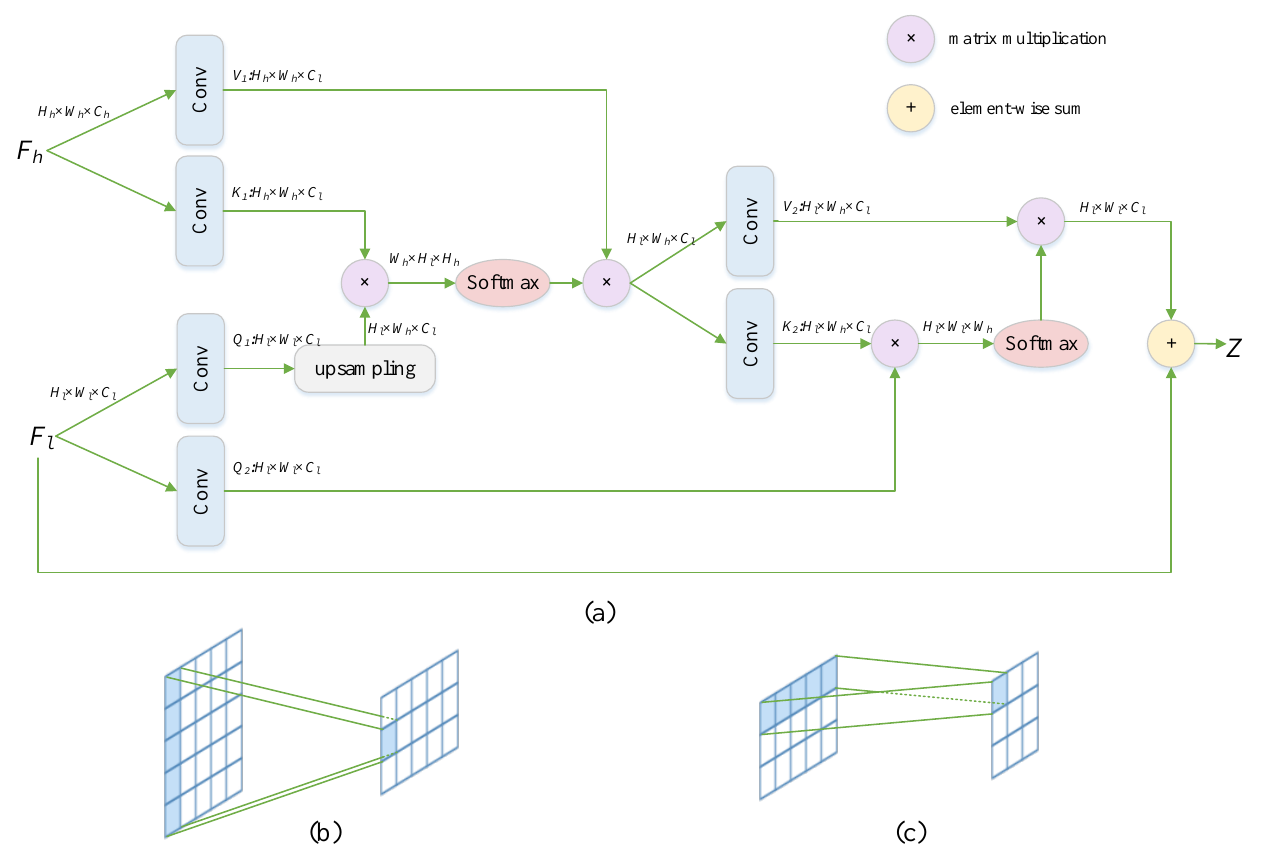
Figure 4. ( a ) The structure of the CSA module. F h represents high-resolution features and F l represents low-resolution features. ( b ) Schematic diagram of matrix multiplication between Q 1 and K 1 in ( a ). ( c ) Schematic diagram of matrix multiplication of Q 2 with K 2 in ( a